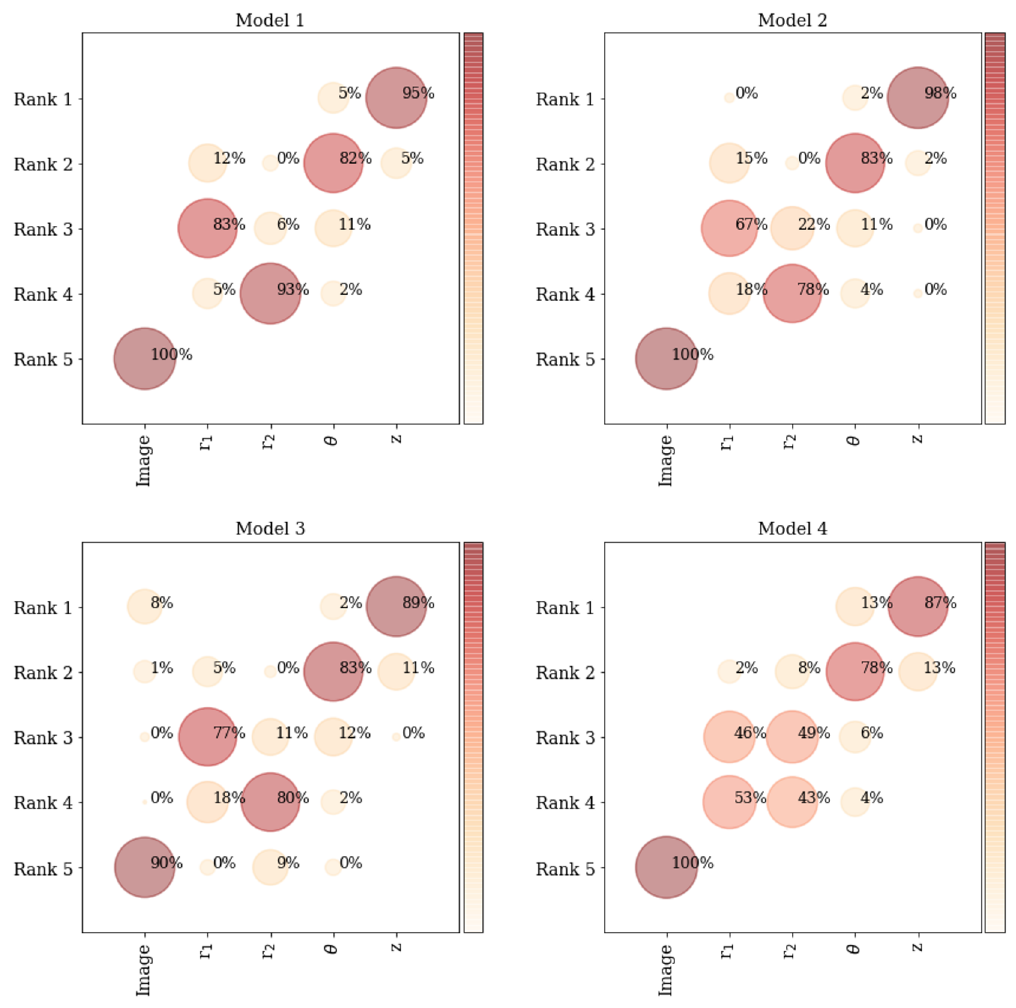
Figure 12. Ranked LRP scores for all variables in the Toy 2D CNN Model shown here for four separately trained